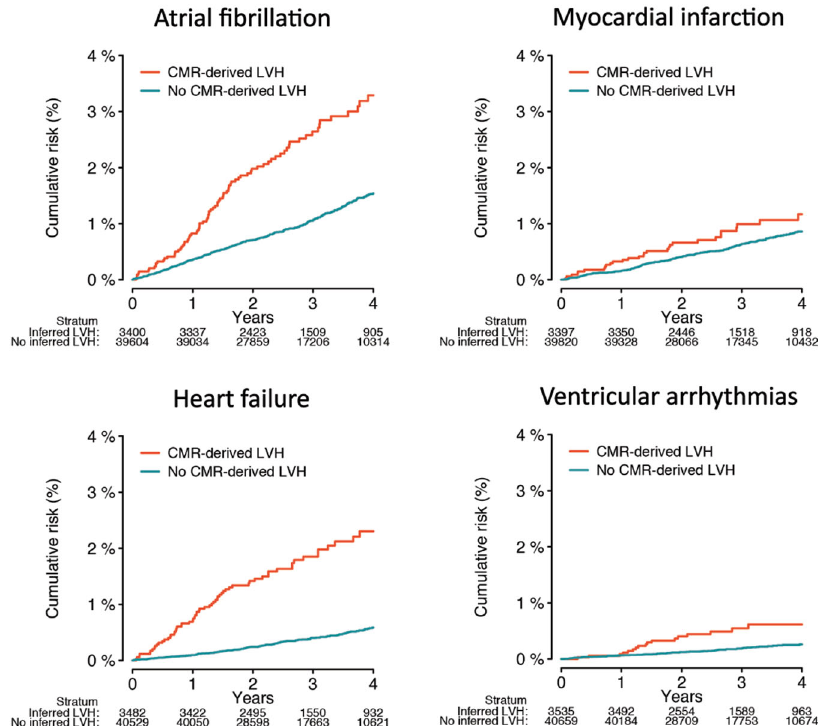
Fig. 4 | Kaplan – Meier plots of the association between CMR-derived LVH and incident cardiovascular disease. Plots depicting the cumulative risk of atrial fi brillation (top left), heart failure (top right), myocardial infarction (bottom left), and ventricular arrhythmias (bottom right), strati fi ed by the presence (orange)